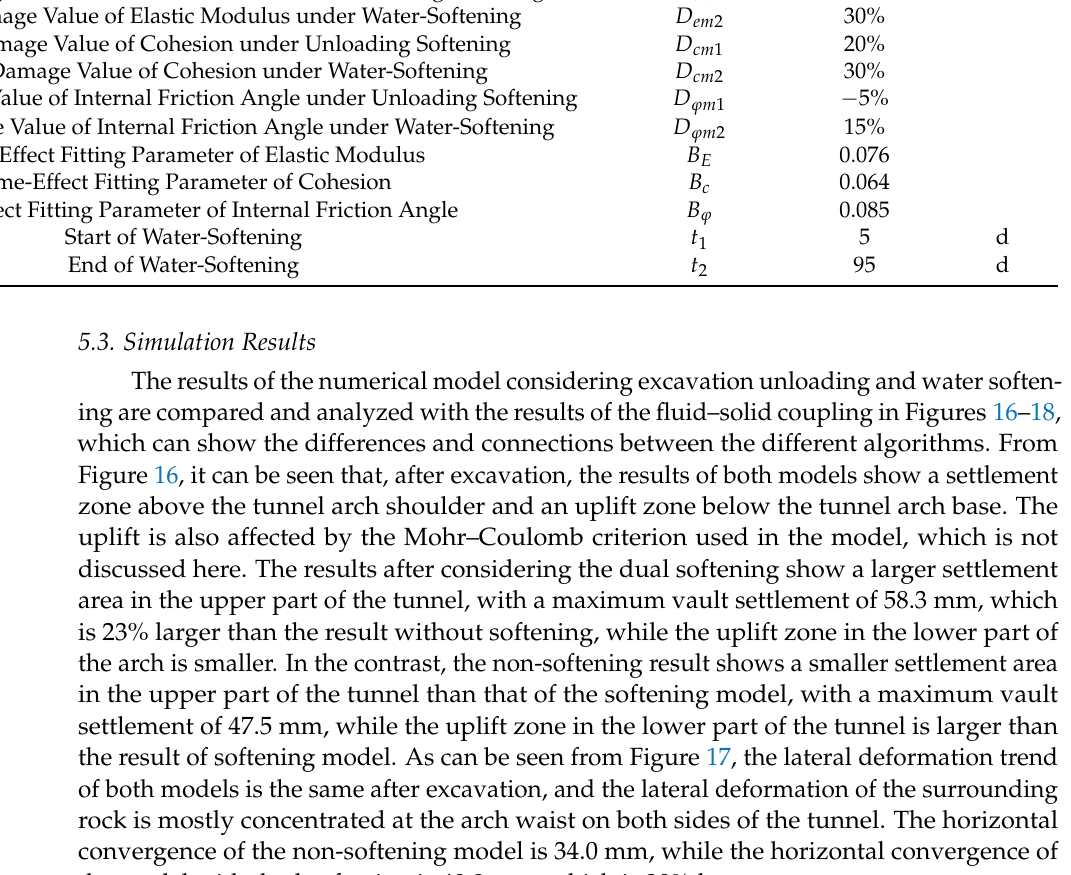
Table 2. Parameters required for the calculation of damage deterioration of surrounding rock. Rock Parameters Symbol Value Unit Maximum Elastic Tensile Strain ε t 1 × 10 − 3 Ultimate Tensile Strain ε tu 2 × 10 − 3 MPa Residual Tensile Strength σ tr ,1 3.54 MPa Residual Tensile Strength at Saturation σ tr ,2 2.40 MPa ε rp